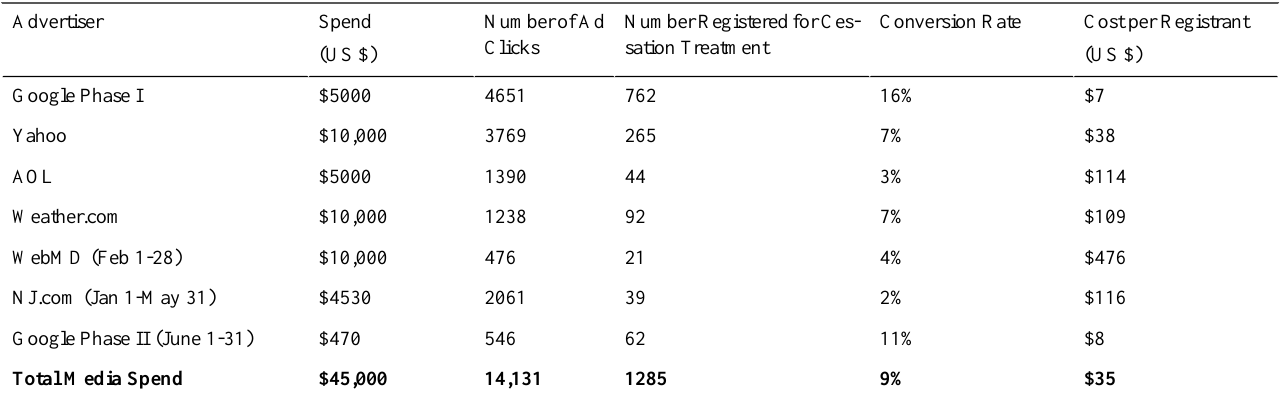
Table 4. Cost-effectiveness in early New Jersey campaigns (December 2004 to June 2005)